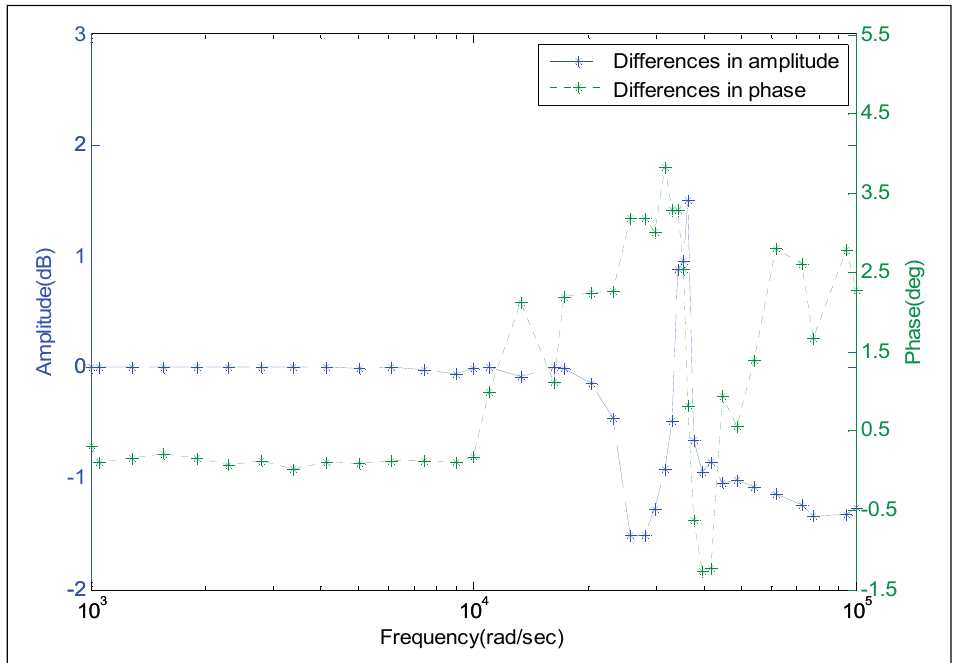
Figure 14. Differences in the amplitude-frequency and phase-frequency between the frequency-domain experiment and Model 1.